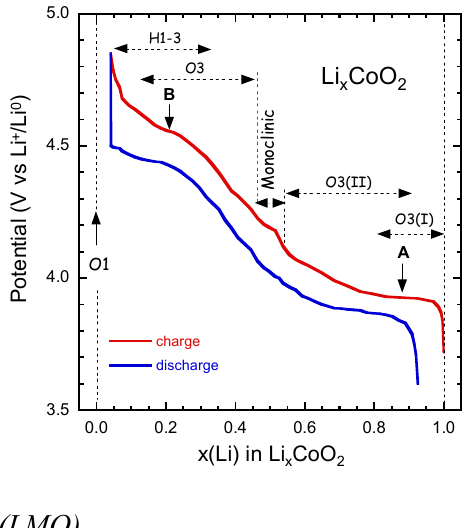
Figure 4. Charge-discharge curves Li Li 0 /Li + . The sequence of the several phases is indicated as x varies from